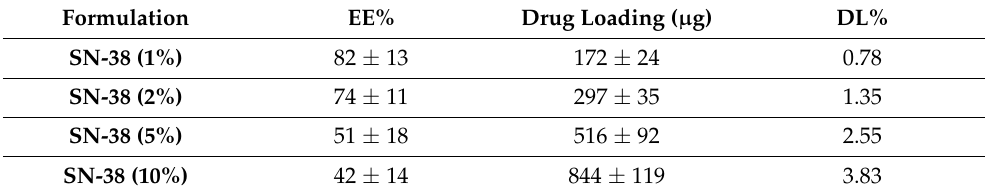
Table 3. EE%, drug loading (DL), and DL% for LNPs prepared by adding 1, 2, 5, and 10 wt.% SN-38 to the total quantity of lipid mixture of MO + OAPy-4, which was stabilised with Pluronic F-127 and dispersed in PBS buffer. Experiments were performed in triplicate on three independent SN-38-loaded LNP systems and all values are expressed as the mean ± SD (n = 3).